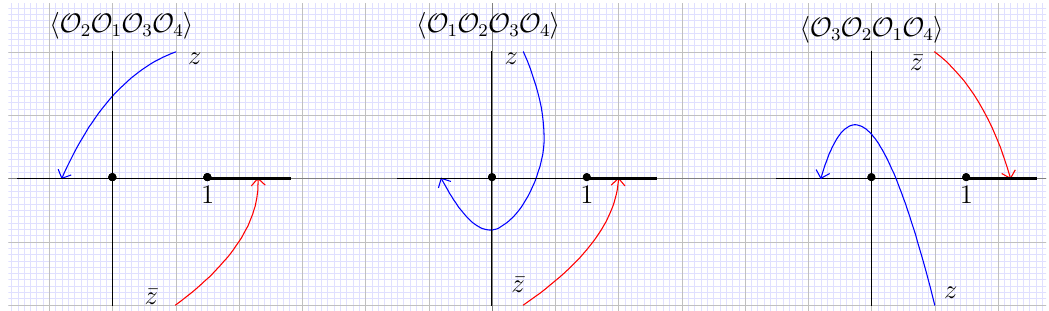
Figure 11 . z, z curves for the analytic continuation from the Euclidean; the first 3 orderings.